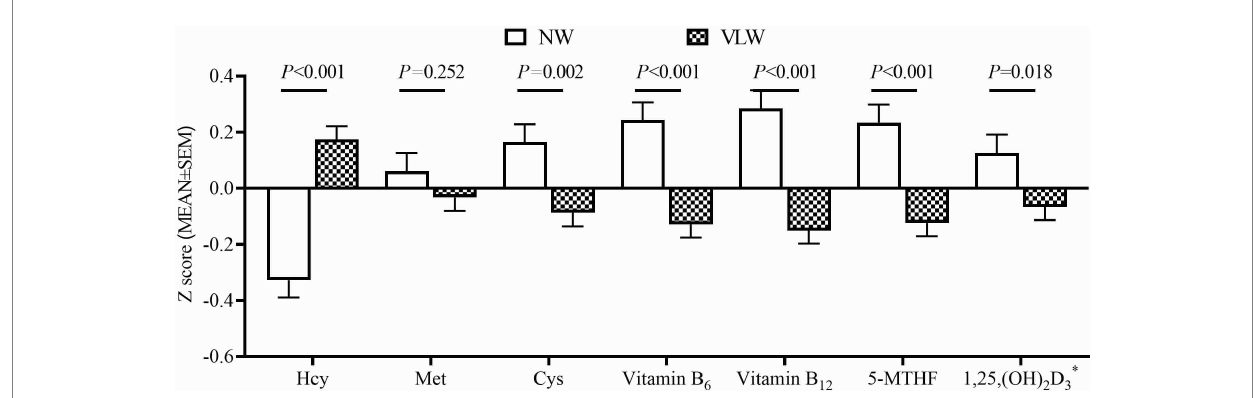
FIGURE 1 Comparison of Hcy and important associated cofactors between the two groups after consumption of DDW in children. Values were age- and sex- specific Z-scores (means ± SEM, NW: n = 229, VLW: n = 431). *Data of 1,25,(OH) 2 D 3 were cited from Huang et al.